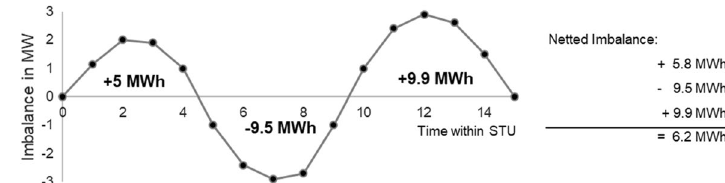
Fig. 1 A stylized example of the netted imbalance calculation within an STU in discrete time